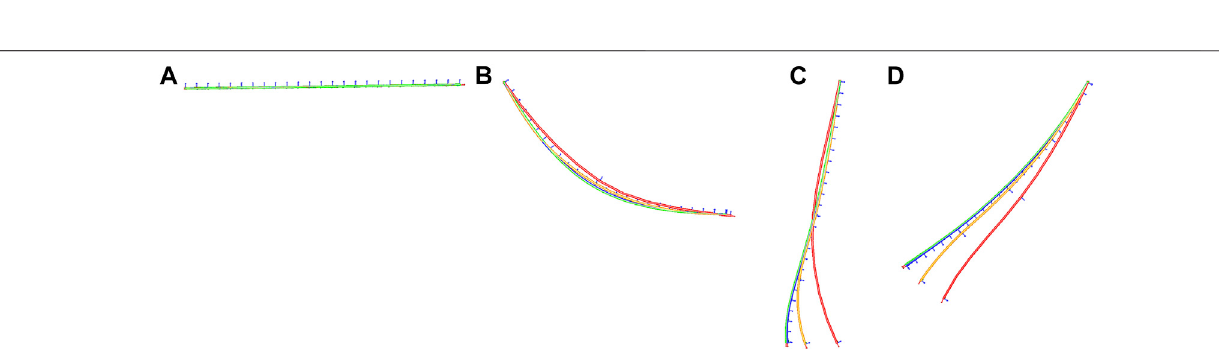
(cid:129) The visual haptic feedback ( Section 4.3 ) (cid:129)